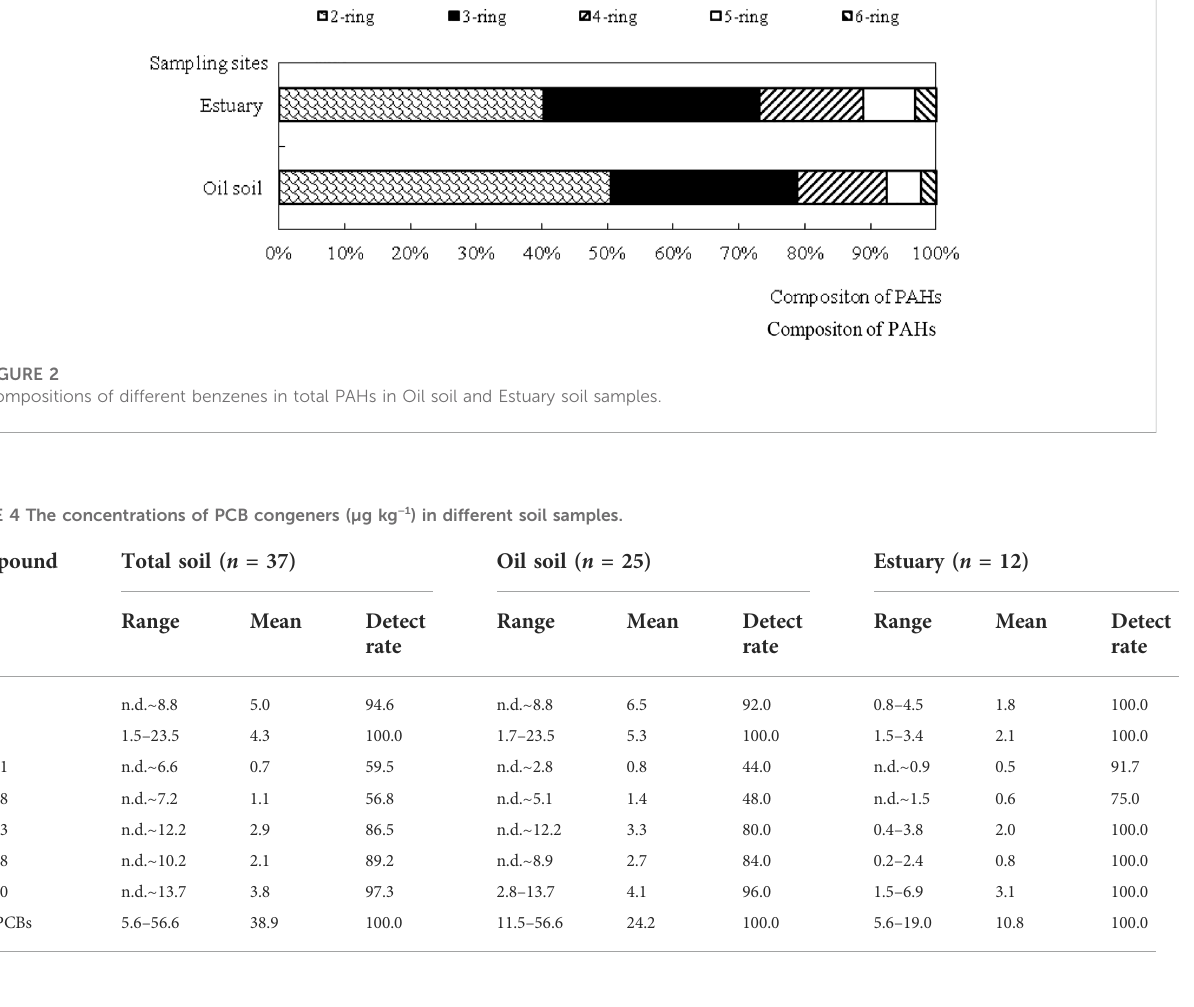
TABLE 5 Total PCB concentrations in soil samples reported from literature [ μ g kg − 1 ].